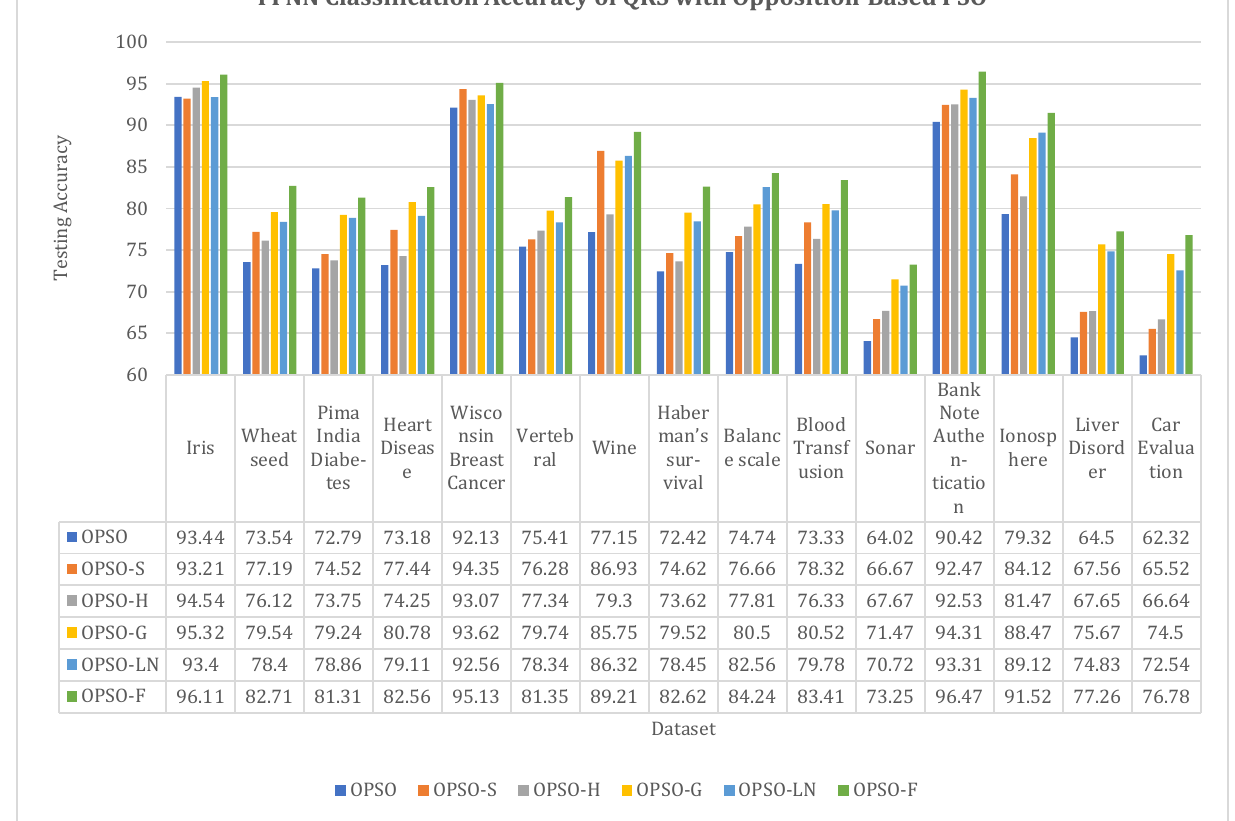
Figure 10. Result of one-way ANOVA test on testing accuracy (QRS with PSO approaches).